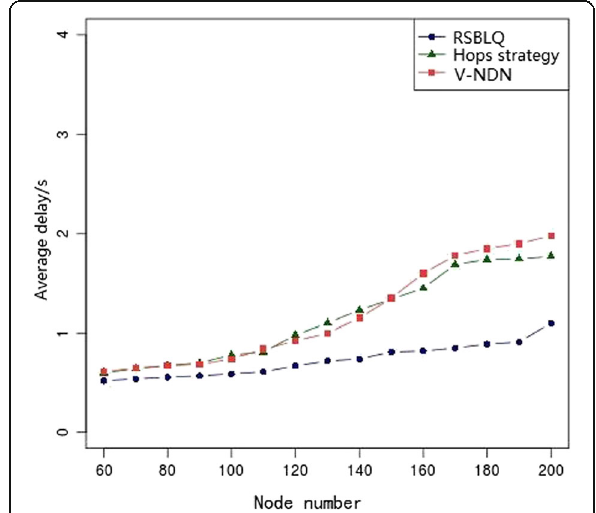
Fig. 16 The average network traffic Fig. 17 Average delay with different